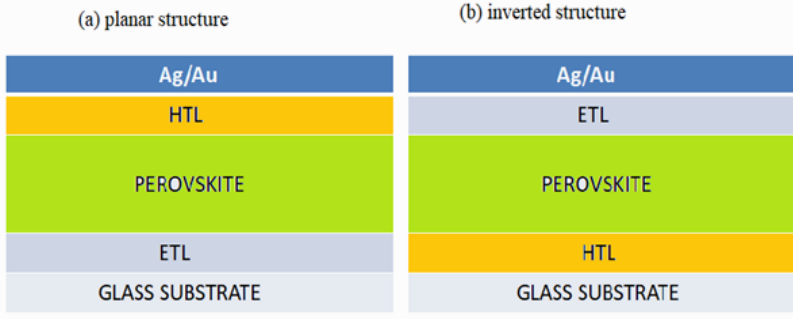
Figure 2. ( a ) A planar device architecture; ( b ) An inverted device architecture.